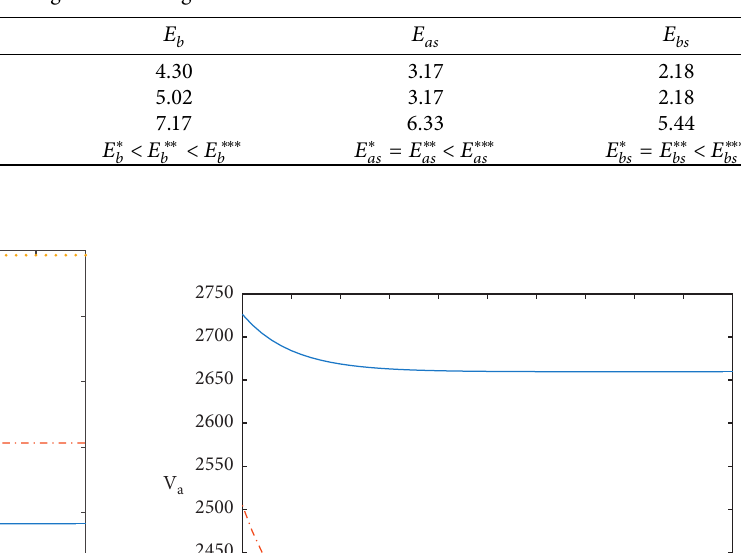
Table 1: The effort levels of Cent-gov and local governments under the three models.